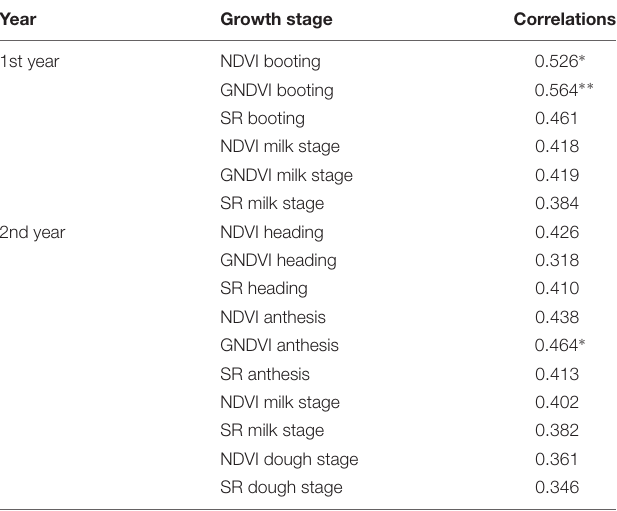
TABLE 5 | Pearson correlations between SVIs and grain yield at different growth